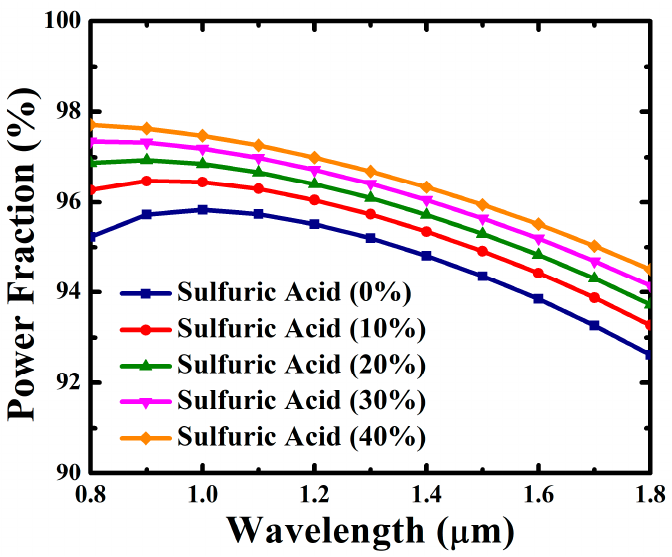
Figure 4. Power fraction of the proposed PCF sensor with 0%, 10%, 20%, 30%, and 40% concentrations of sulfuric acid for different operating wavelengths.